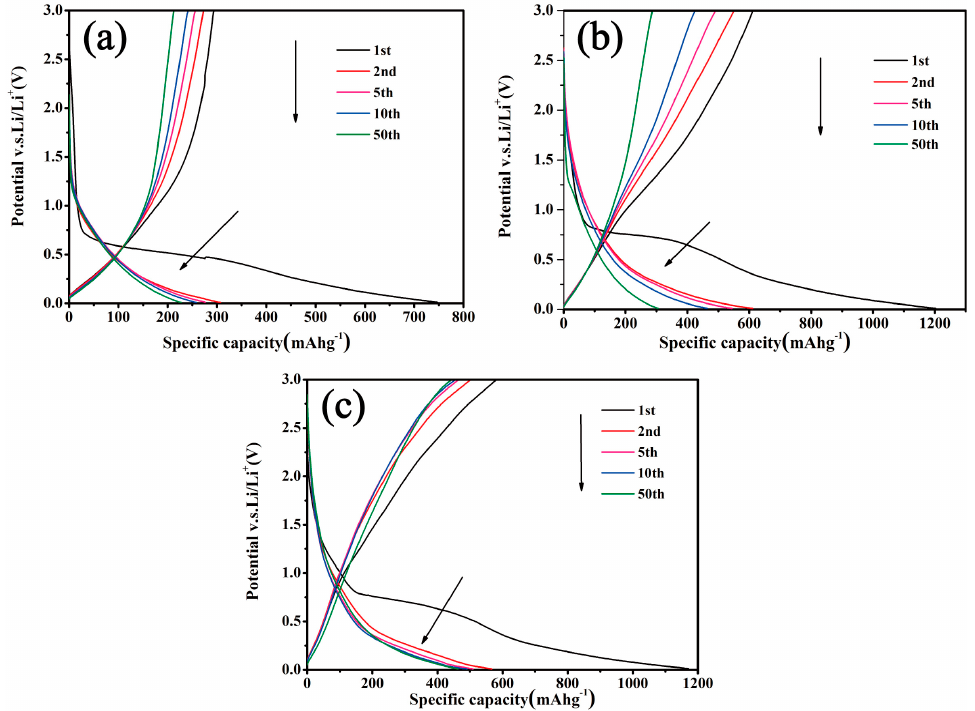
Figure 7. The discharge–charge curves of ( a ) MCs-0 ( b ) MCs-1, and ( c ) MCs-2 electrodes.